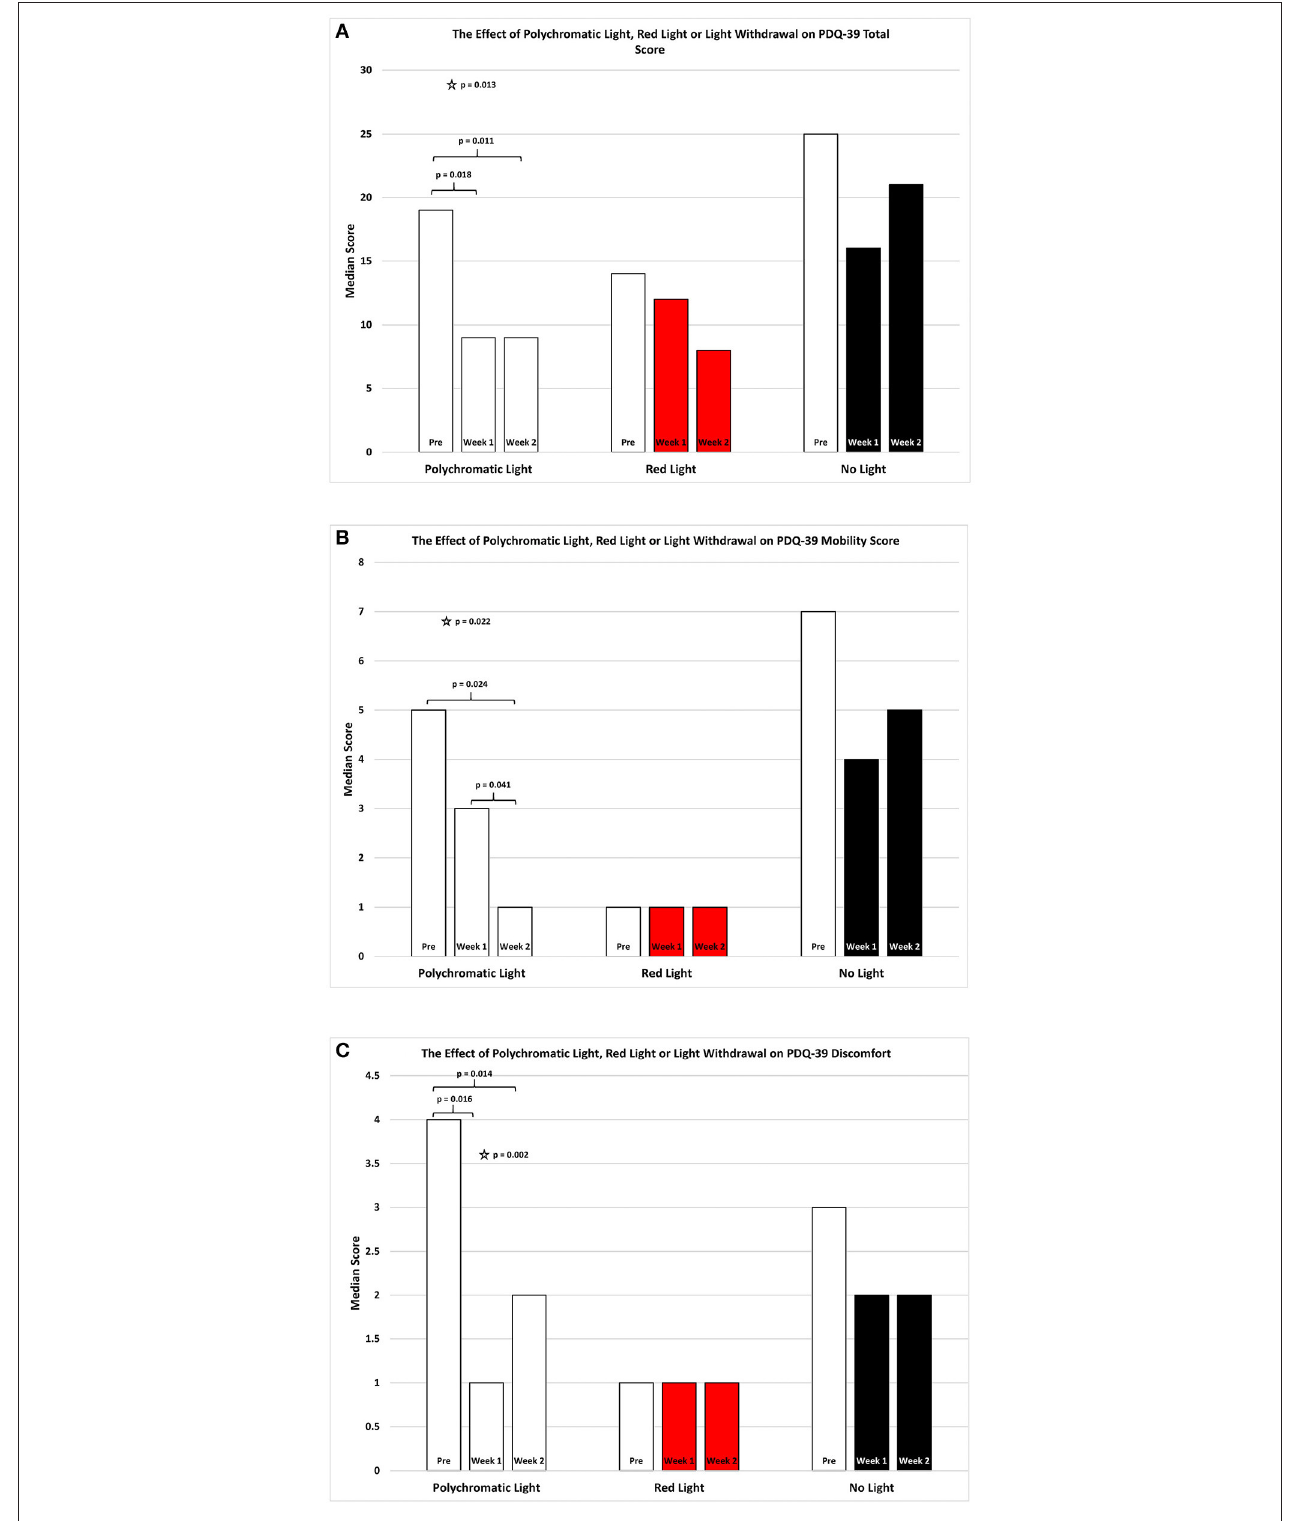
FIGURE 2 | The effect of continued daily exposure to polychromatic light, red light or withdrawal of polychromatic light on the Total Score (A) , Mobility (B) and Discomfort (C) sub-sections of the PDQ-39 is expressed as the median score for each group after 3 assessments over a 2 week period. The pre-score served as